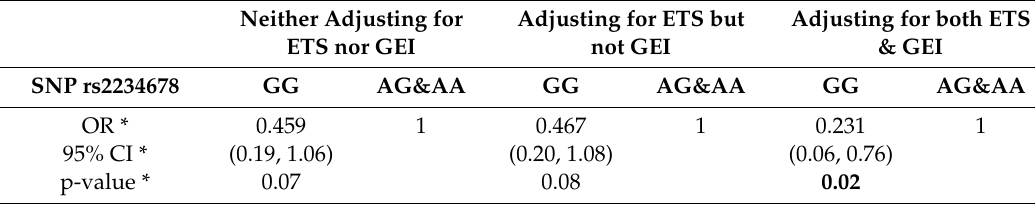
Table 5. Genotypic association of SNP rs2234678 for asthma (N = 441).